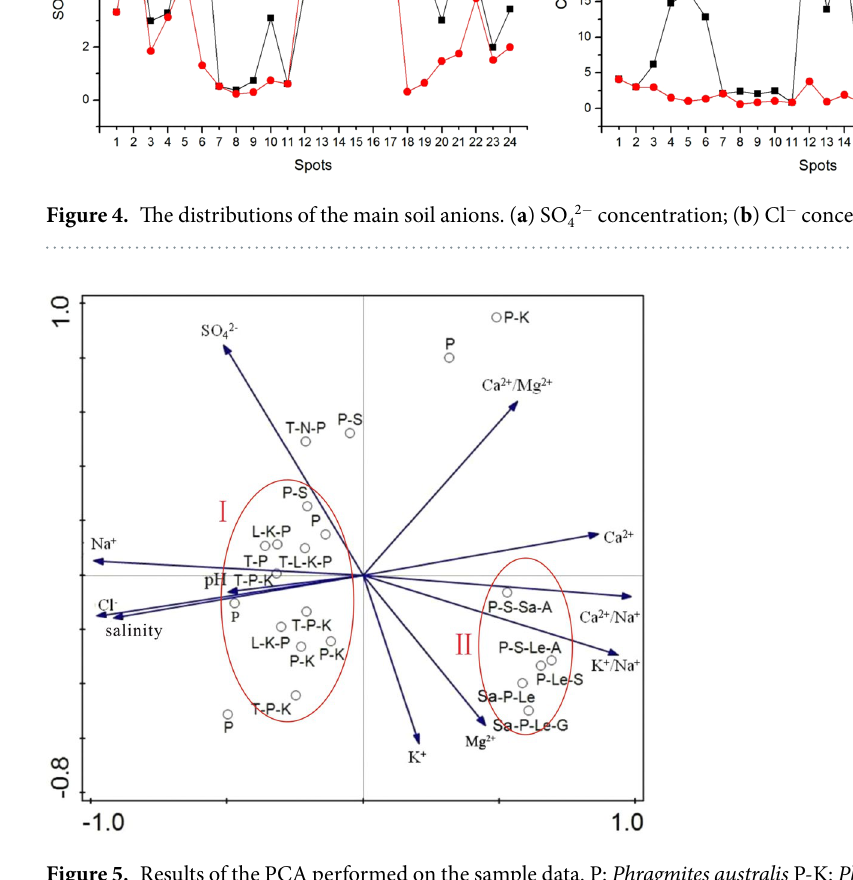
Figure 5. Results of the PCA performed on the sample data. P: Phragmites australis P-K: Phragmites australis— Apocynum venetum P-S: Phragmites australis—Saussurea salsa T-P: Tamarix—Phragmites australis